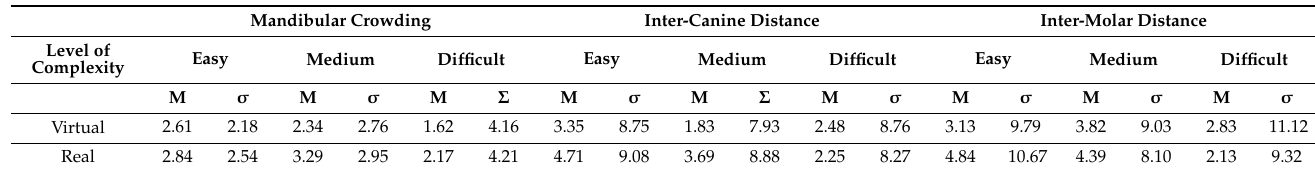
Table 2. Descriptive statistics (M = mean of the estimation errors; σ = standard deviation) of crowding, inter-canine distance, and inter-molar distance estimation in virtual and real conditions. Mandibular Crowding Inter-Canine Distance Inter-Molar Distance